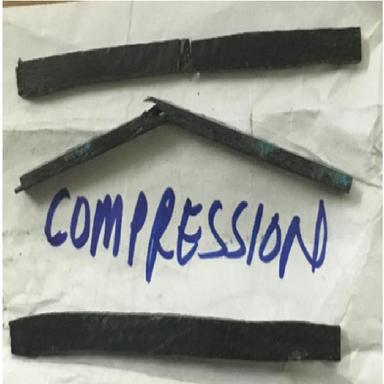
Specimen after Compressive Test.